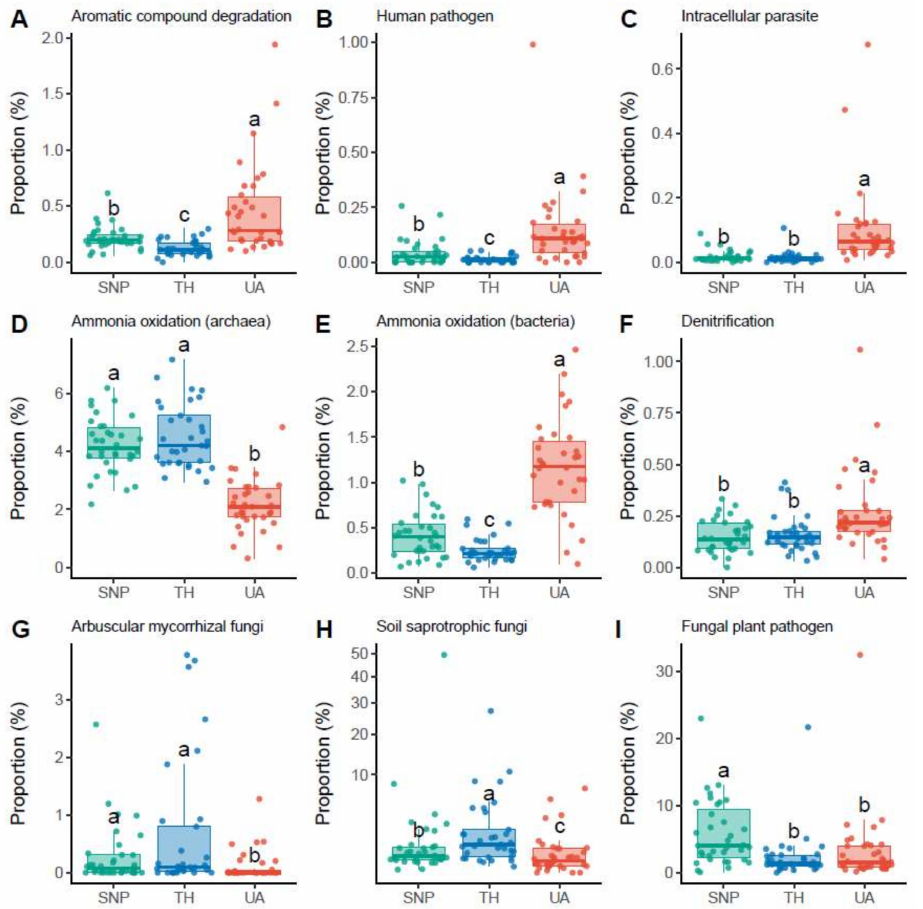
Figure 4. Changes in the proportions of microbial functional groups across locations. Different letters indicate significant differences ( p < 0.05) based on Dunn’s test. ( A – F ) Dominant bacterial/archaeal functional groups. ( G – I ) Dominant fungal functional groups. Results of other functional groups are provided in Supporting information (Figures S2 and S3). Location abbreviations are the same as those in Figure